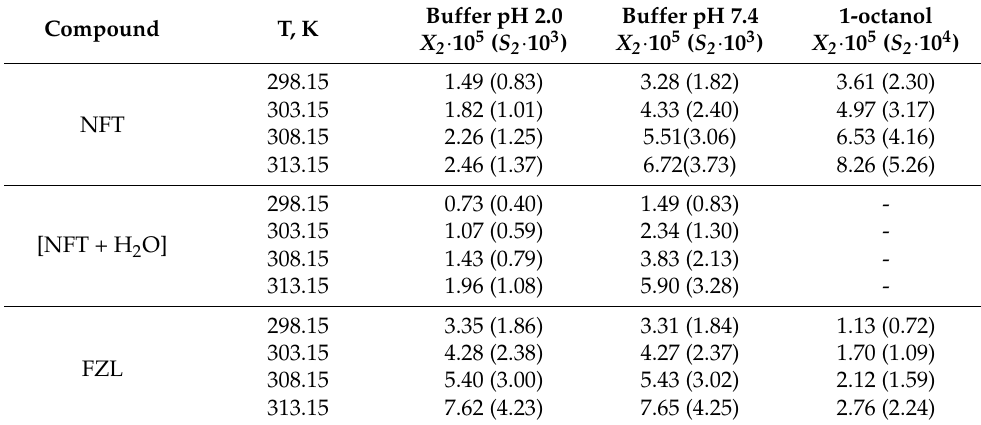
Table 4. Temperature dependences of solubility ( X 2 , mol. frac. and S 2 , mol·L −1 ) of NFT and FZL in buffer solutions (pH 2.0 and 7.4), 1-octanol at pressure p = 0.1 MPa.